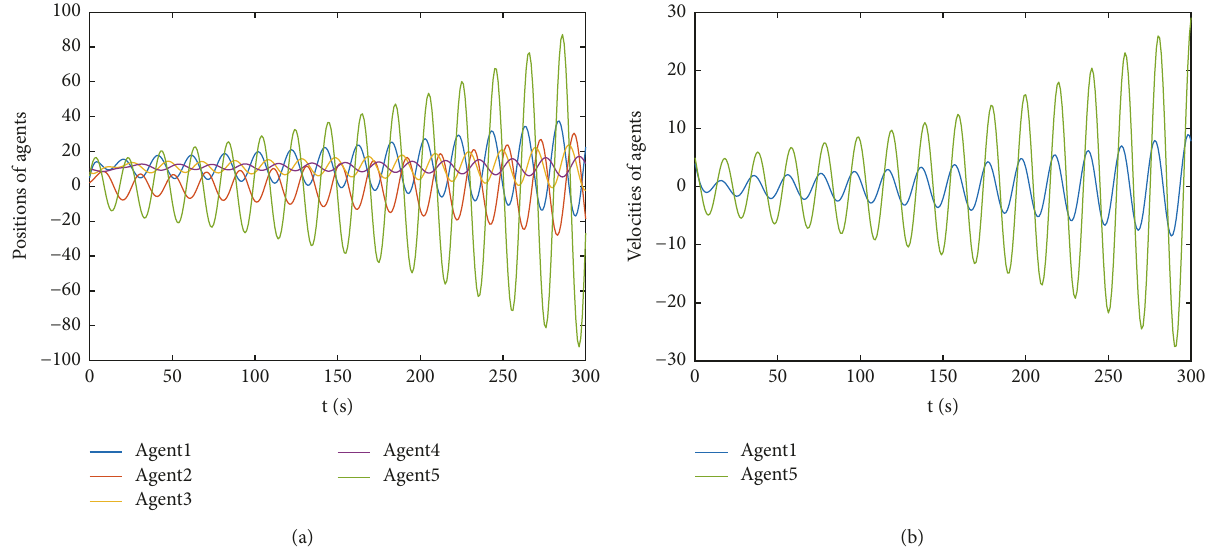
Figure 8: The state trajectories of the agents under directed topology in Figure 5 with different input time delays 𝜏 1 = 1 , 𝜏 2 = 4.5 , 𝜏 3 = 4.5 , 𝜏 = 4.5, 𝜏 = 4.5 , and 𝜏 = 1 . (a) Positions, (b) 4 5 𝑖𝑗